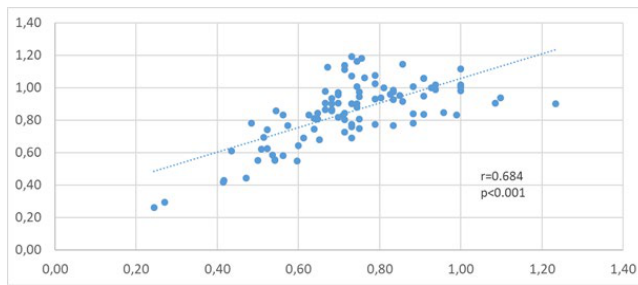
Figure 3. Correlation of manually annotated and automatically tracked Gait Speed (GS) in